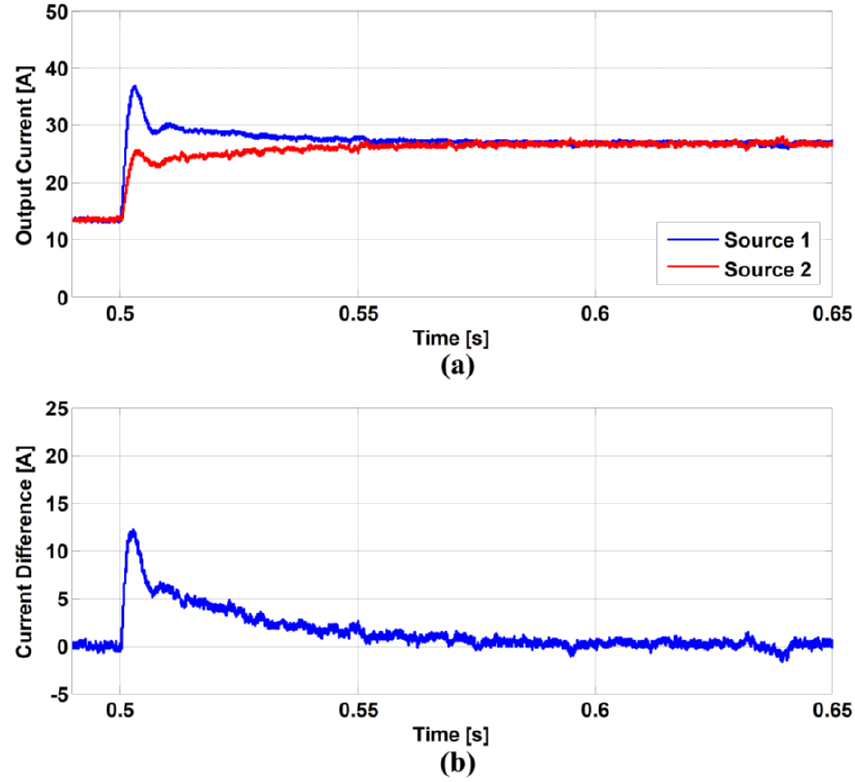
Figure 11. Simulated output current waveform ( L v 2 = 1 mH). ( a ): Output Current, ( b ): Difference.